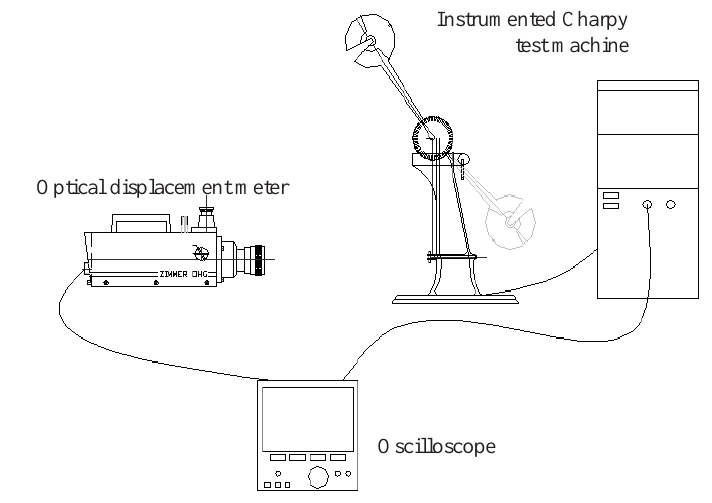
Fig.4. Schematic illustration of test